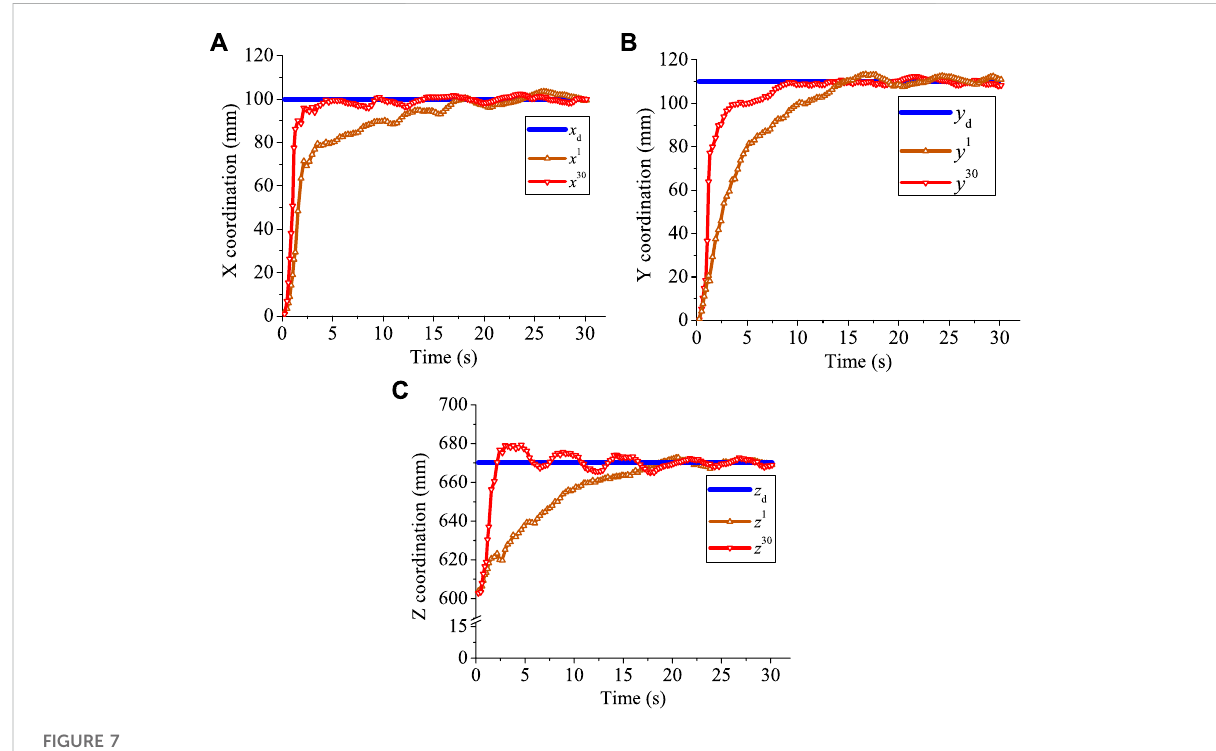
FIGURE 7 Experimental results. (A) X coordination. (B) Y coordination. (C) Z coordination.